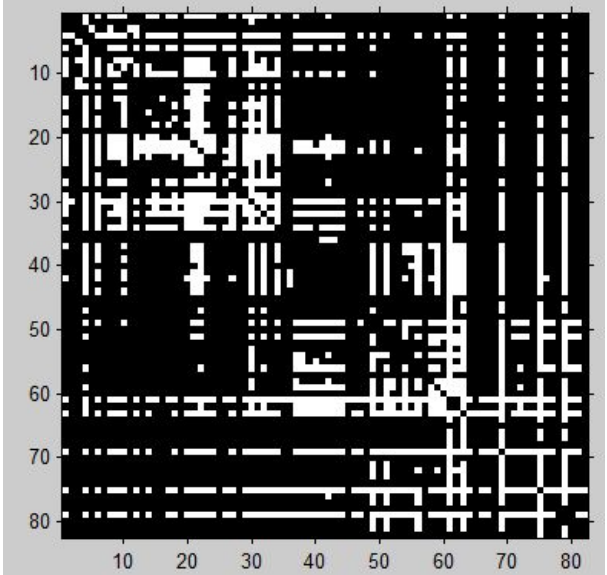
Fig. 1 The 0-1 matrix of China and five Central Asian countries.